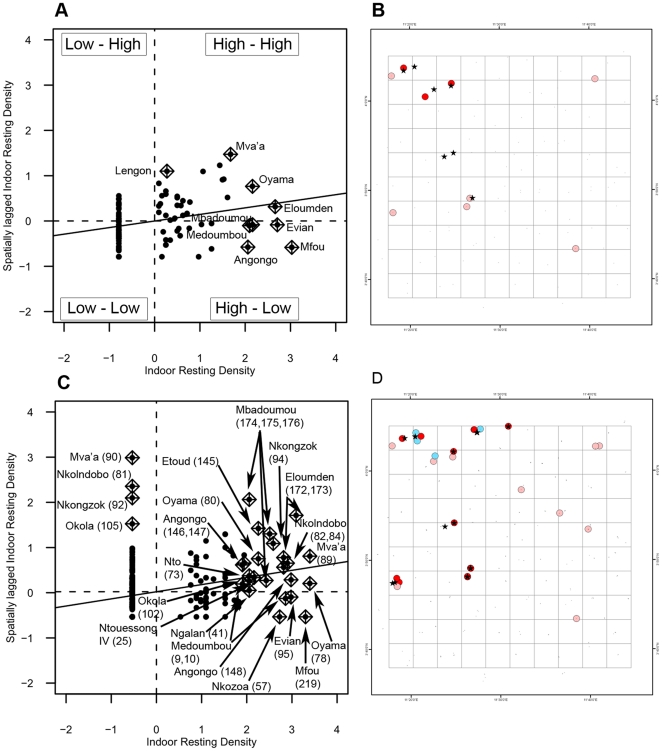
LISA results for An. funestus.(A) and (C) are Moran scatter plots at the locality and at the house level, respectively. The name of the locality and the house number (in brackets) with large contributions to autocorrelation are displayed. (B) and (D) depict the locations of significant local Moran's I statistics and the type of spatial association between neighboring locations in sampling units with large contributions to the global autocorrelation. (A): locality level and (B): house level. ∧ significant (p<0.01); bright red: High-High; light red: High-Low; deep blue: Low-Low; light blue: Low-High.